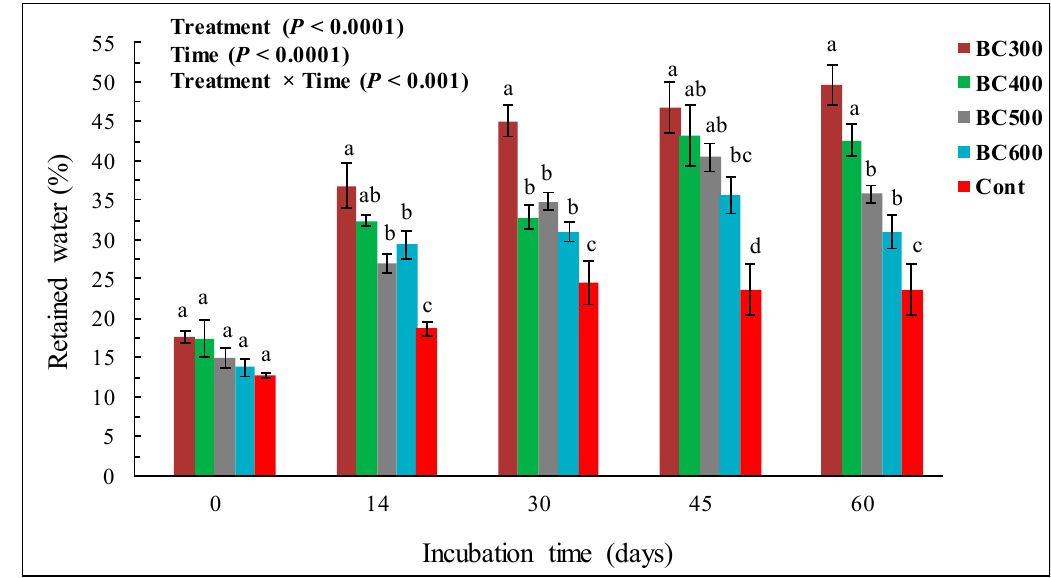
Figure 4. Percentage of retained water in sandy desert soil treated with 50 t ha − 1 of four date palm residue BCs produced with different pyrolysis temperatures (BC300, BC400, BC500, and BC600) over time. Bars sharing the same letter among treatments are not significantly different according to the SNK test ( p ≤ 0.05). Errors bars represent the standard error of the mean ( n =3).